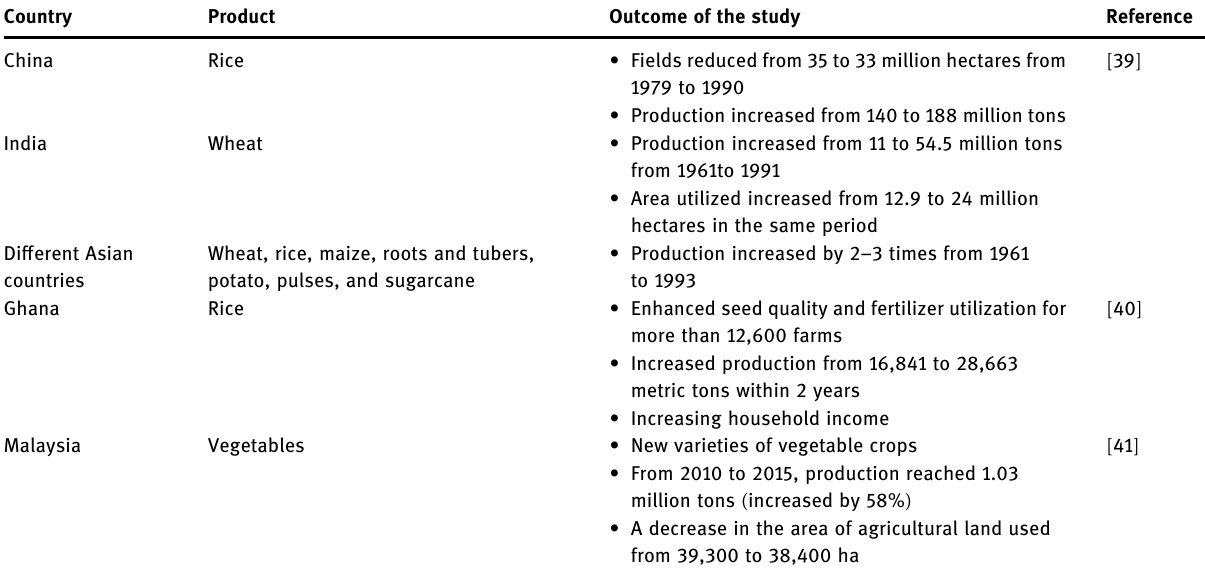
Table 3: Selected examples of bene fi ts of technology transfer on di ff erent agricultural products in di ff erent countries Country Product